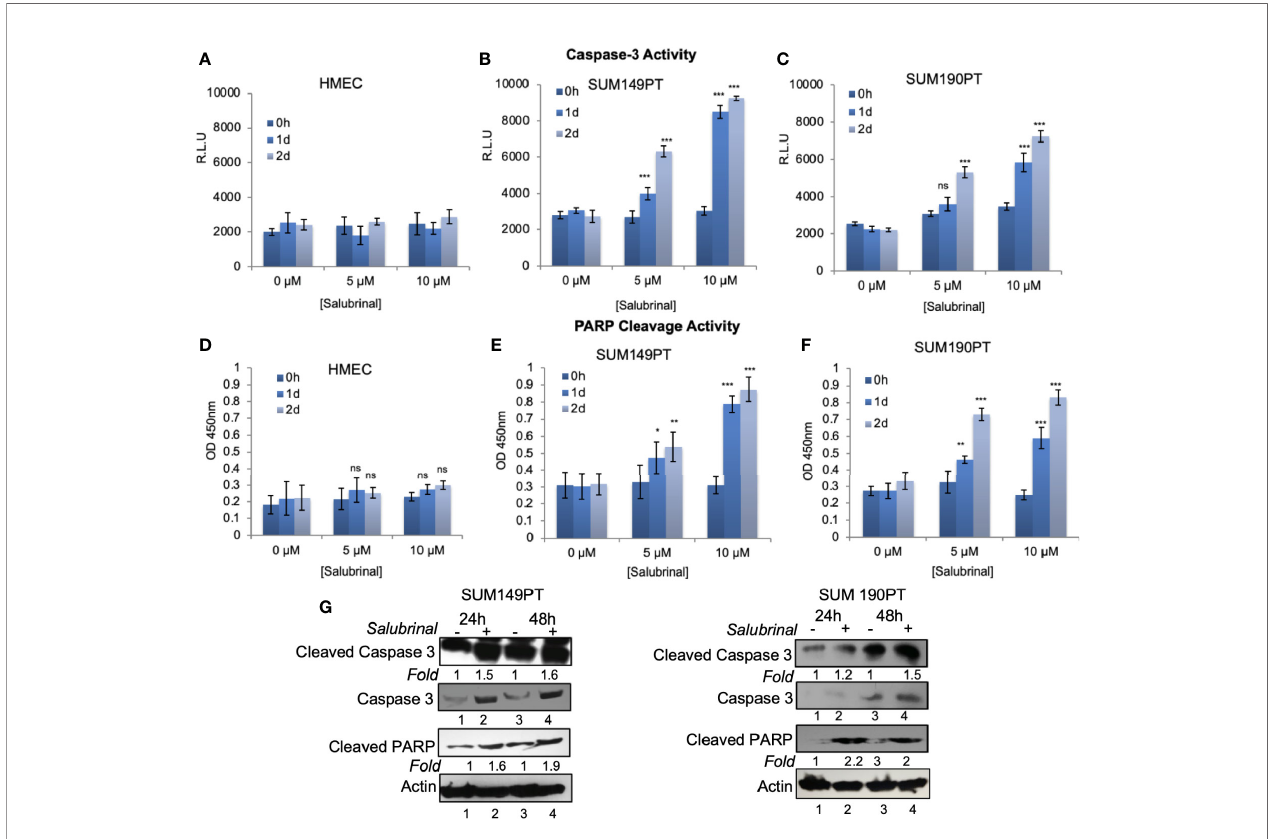
FIGURE 6 | Salubrinal treatment induces caspase-3 activation and PARP cleavage in IBC cells. (A – C) HMEC and IBC cell lines, SUM149PT and SUM190PT, were treated with various concentrations of Salubrinal for different time intervals. A luminogenic caspase-3 substrate is added, and the luminescence is measured in relative light units (RLU) as an index for caspase-3 activity. Each reaction was done in triplicate, and each bar represents the mean ± SD for three experiments. (D – F) HMEC and IBC cell lines, SUM149PT and SUM190PT, were treated with various concentrations of Salubrinal for different time intervals. Cells were fi xed, permeabilized, and incubated with a particular anti-cleaved PARP primary antibody followed by an HRP-labeled secondary antibody. Absorbance (OD) was measured at 450 nm as an index of PARP cleavage. Each reaction was done in triplicate, and each bar represents the mean ± SD for three experiments. (*), p < 0.05, (**) p < 0.01, (***) p < 0.005 indicate a statistically signi fi cant difference compared with cells treated for 0h. ns, not signi fi cant. (G) SUM149PT and SUM190PT cells were cultured with or without 10M Salubrinal for 24 and 48 hours. Lysates prepared and tested for caspase-3, cleaved caspase-3 and cleaved PARP as indicated by Western blot analysis. Blots were reprobed with anti – actin antibody as a loading control. The level of proteins in untreated samples was considered one for fold activation or down-regulation using the quanti fi cation method as described in the Methods